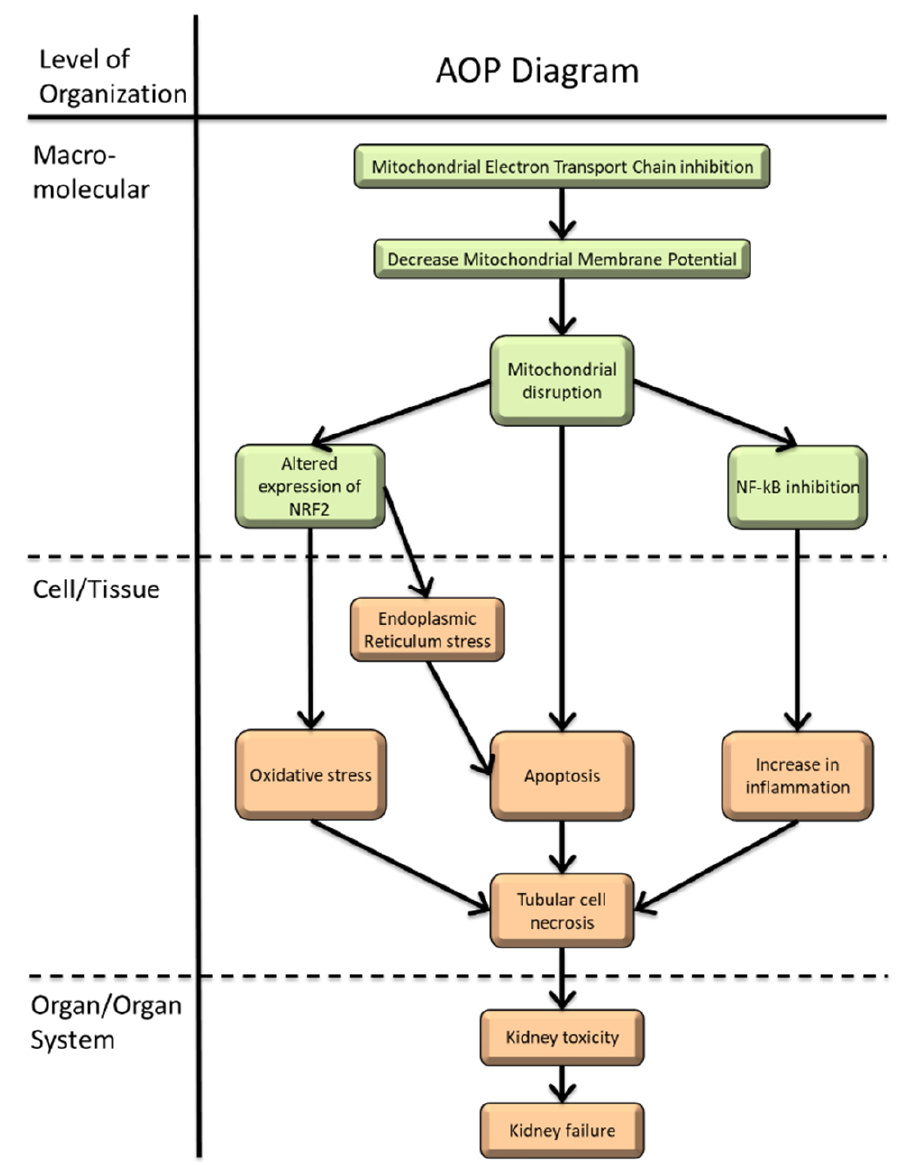
Figure 1. Proposed AOP diagram of kidney failure induced by inhibition of mitochondrial electron transfer chain (https://aopwiki.org/aops/447). Starting from the exposure of U and its distribution, the identified molecular pathways (molecular initiating and key events), and the cellular and tissue responses leading to adverse kidney